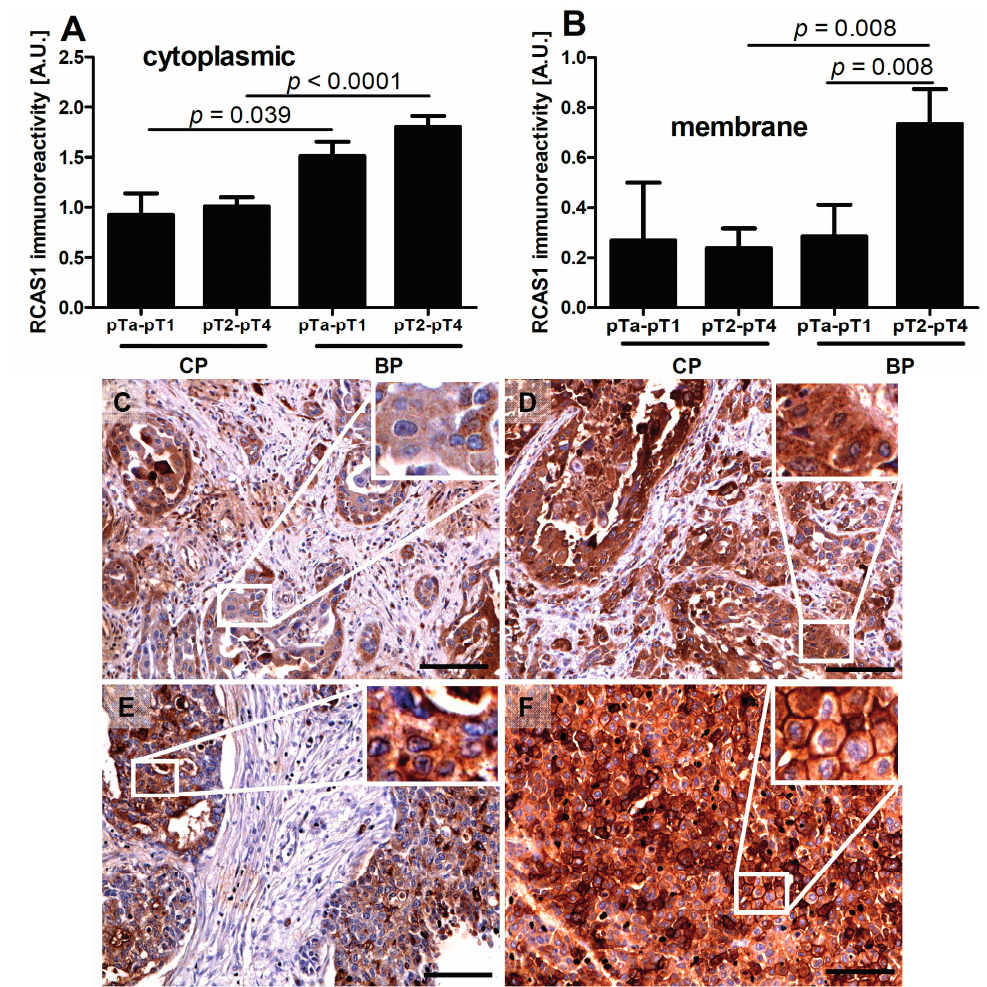
Figure 3. Relationships between RCAS1 cytoplasmic ( A ) and membrane ( B ) immunoreactivity of non-muscle-invasive bladder cancer (stages pTa, pTis, and pT1) and muscle-invasive bladder cancer (stages pT2–pT4). Representative immunostaining of cytoplasmic RCAS1 in the central part (CP) ( C ) and border part (BP) ( D ) of pTa–pT1 and cytoplasmic and membrane RCAS1 in the CP ( E ) and BP ( F ) of pT2–pT4. White squares indicate the areas enlarged in the insets. Scale bars: 100 µm.